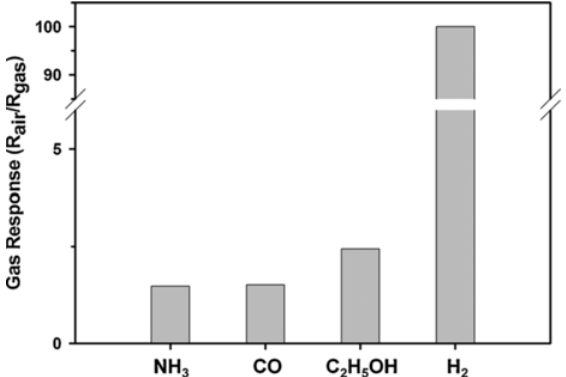
Figure 15. Magnitude of gas response of TiO at 100 °C. Reprinted from [95] with permission. Copyright (2013) Elsevier